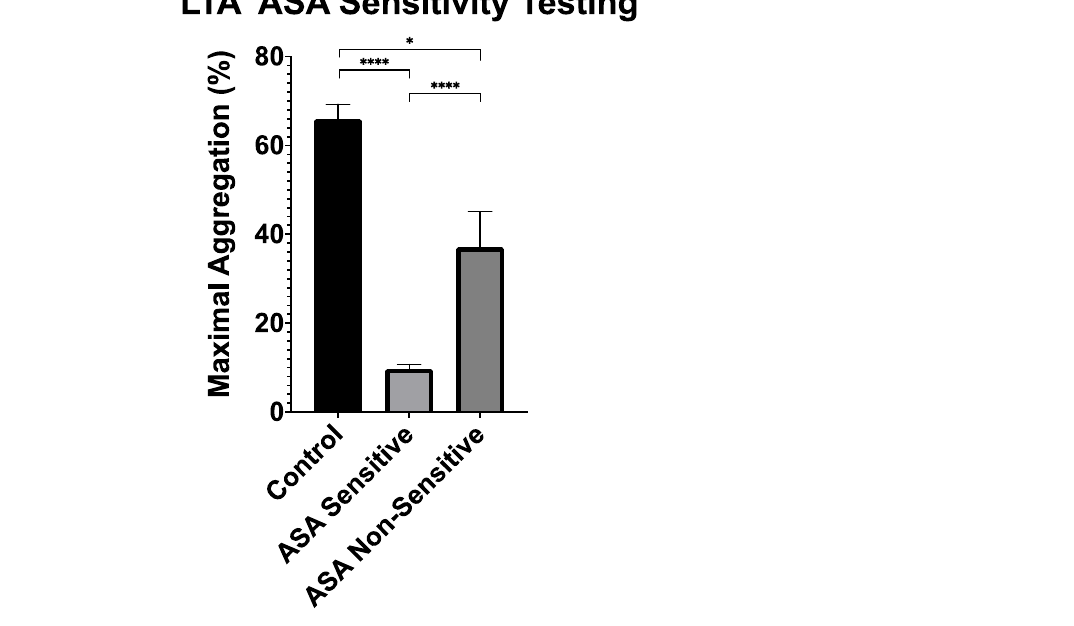
Figure 2. Light transmission aggregometry analysis between ASA sensitive patients ( n = 30), ASA non-sensitive patients ( n = 10), and controls not taking ASA ( n = 20) with platelet activation using arachidonic acid. Error bars represent standard error of the mean. * represents p < 0.05, **** represents p < 0.0001.